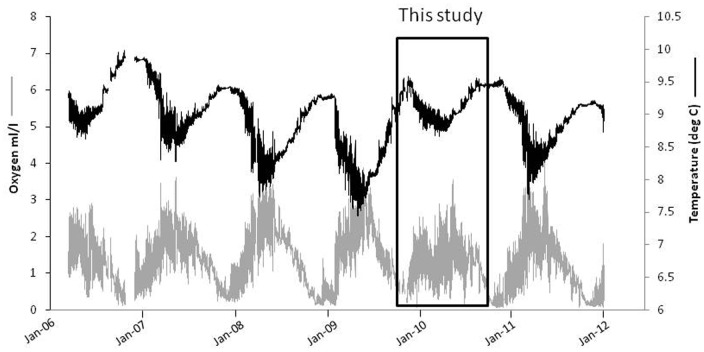
Temperature and dissolved oxygen recorded at the 95 m seafloor instrument platform (VIP) on VENUS in Saanich Inlet.Black line = temperature and grey line = oxygen. The period of this study is circumscribed by the box.